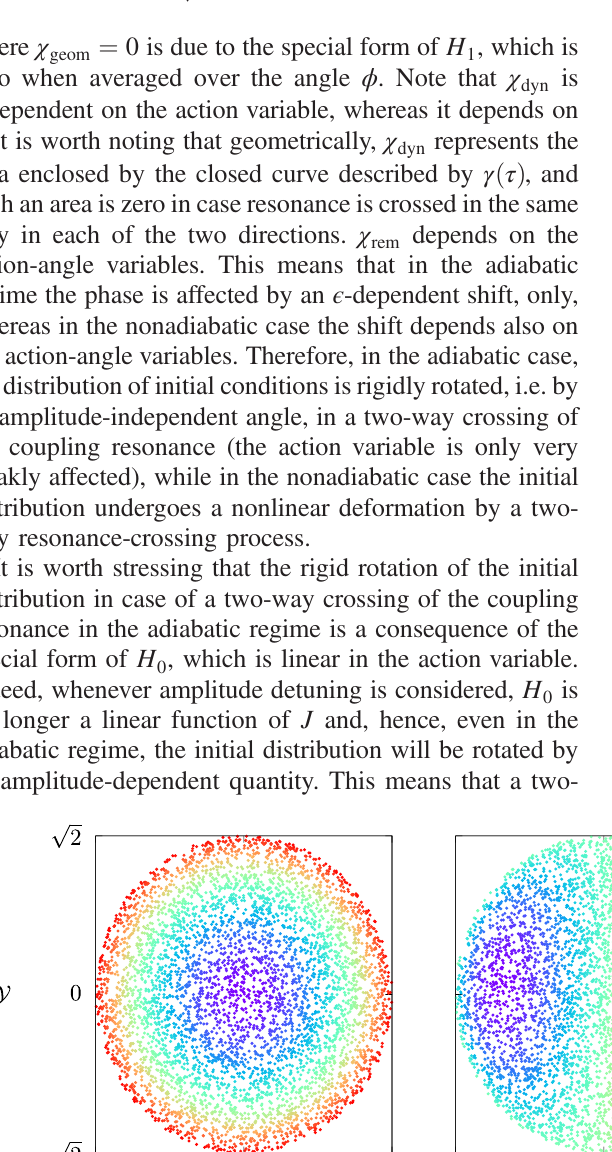
, and show how particles a ; i